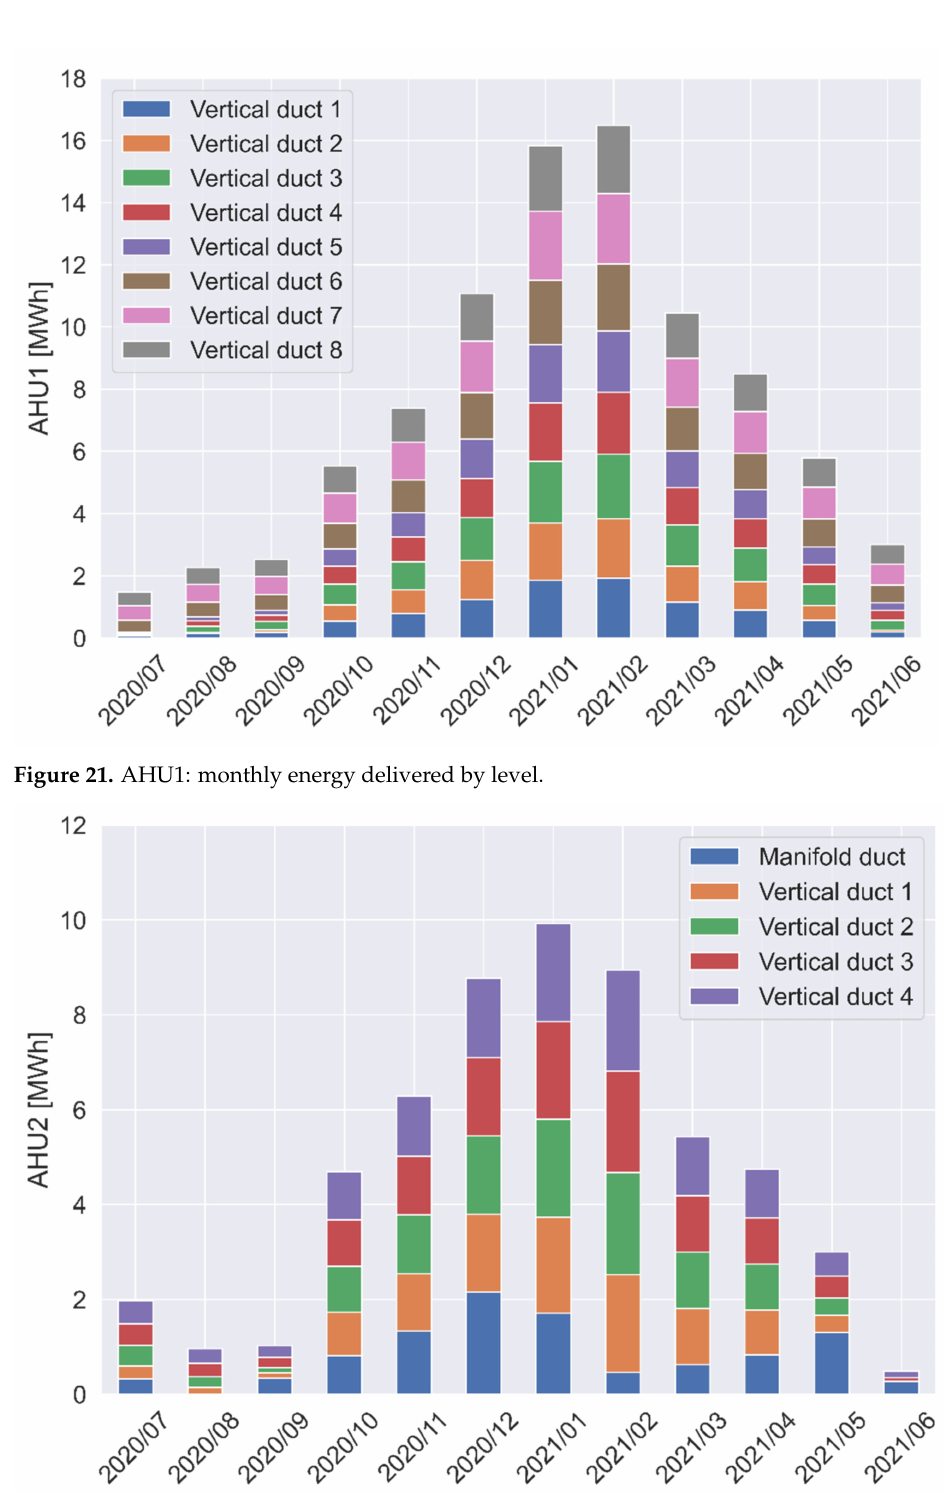
Figure 22. AHU2: monthly energy delivered by